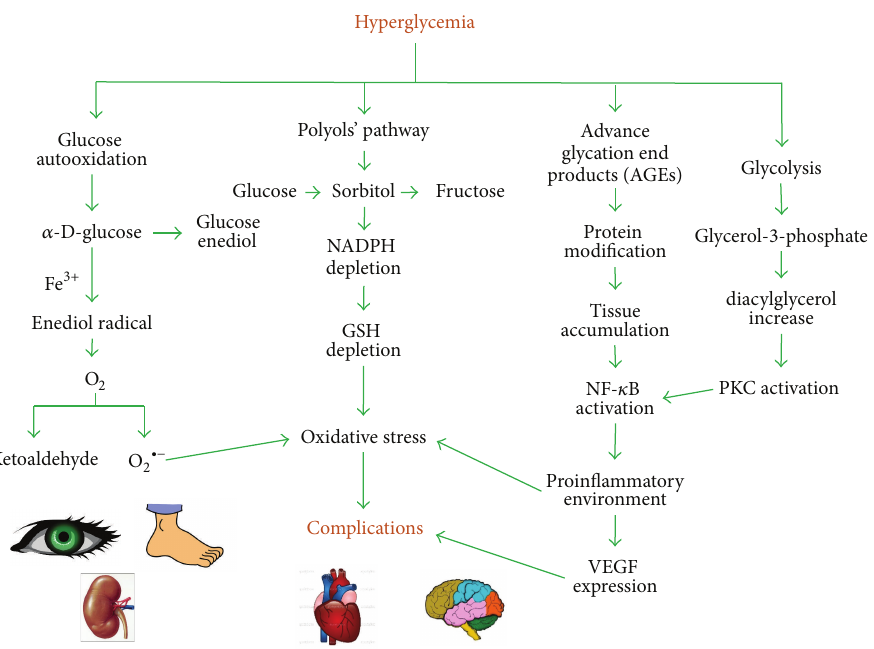
Figure 1: The main pathways triggered by hyperglycemia include glucose autooxidation and constant activation of polyols’ pathway and formation of advance glycation end products (AGEs) and excessive glycolysis. With the constant activation of these pathways, living cells and tissues are damaged, mainly by impairment of target protein function, increase in oxidative stress, and activation of signal transduction pathways, leading to the imbalance of normal physiological functions and therefore the development of diabetic